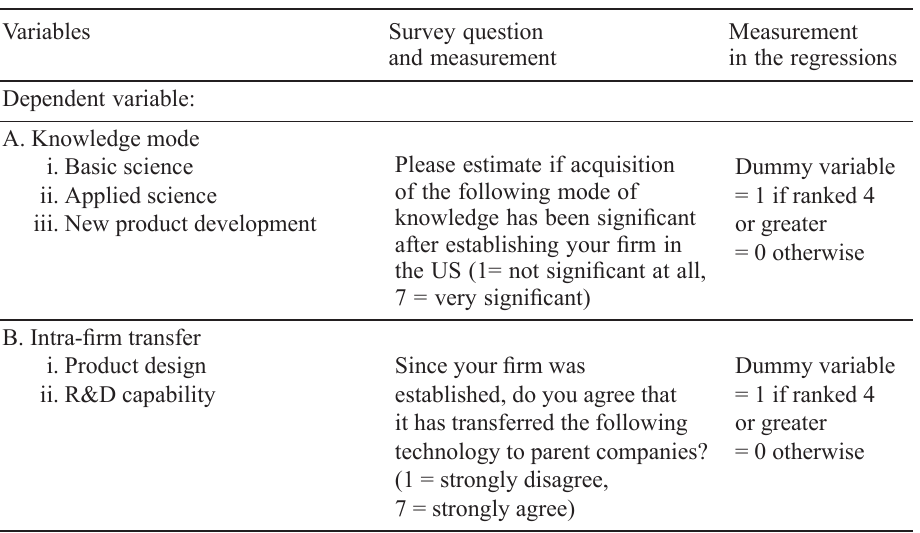
Table 1. Variables and